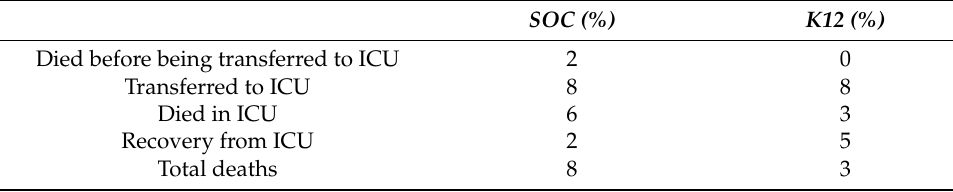
Table 7. Relationship between death and lower or higher supplementary oxygen request according to the treatment group. Parameter SOC K12 * p = 0.0022 Lower Higher Lower Higher Dead 0 8 0 2 Alive 8 9 15